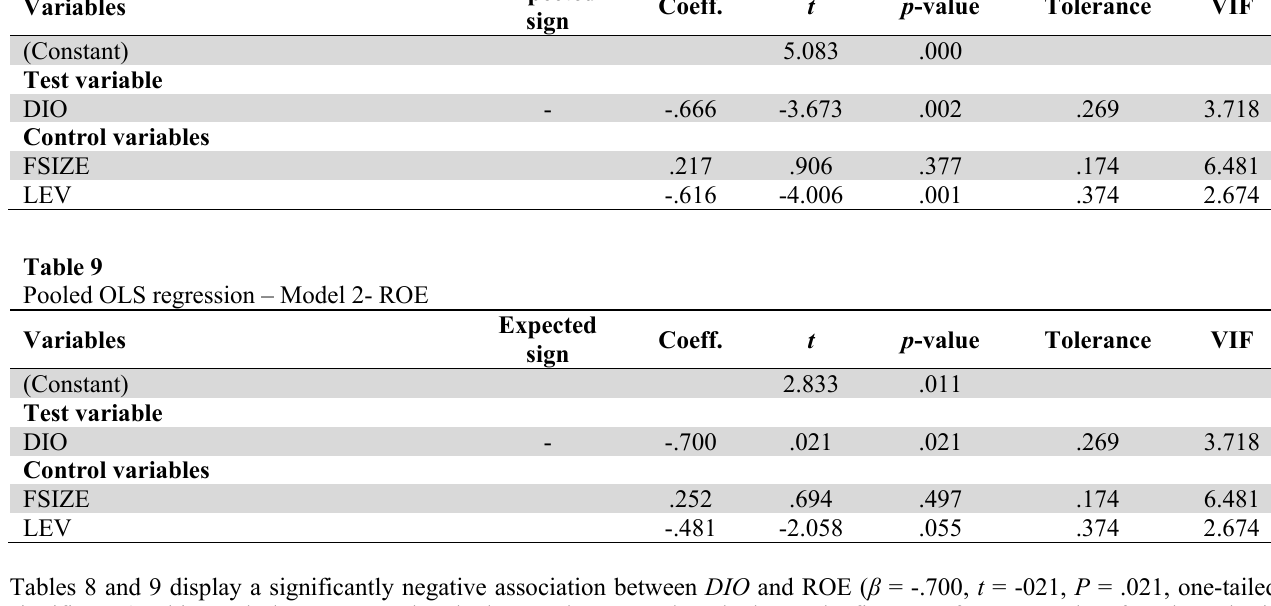
Pooled OLS regression – Model 1- ROA